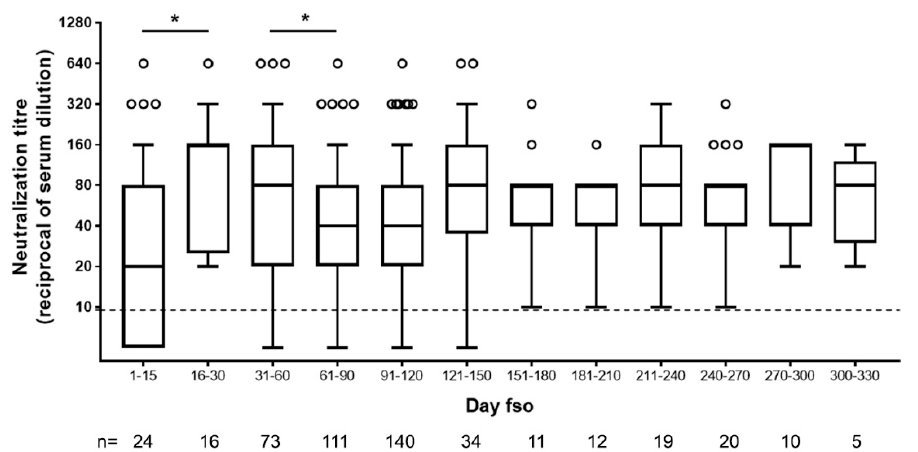
Figure 2. Neutralizing antibody titers in serum samples of SARS-CoV-2-infected patients collected at different time from symptom onset. Dot line indicates limit of NAb quantification. fso = from symptom onset, n = number of patients tested. Statistical analysis was performed by Mann–Whitney test; p values < 0.05 is indicated as *.